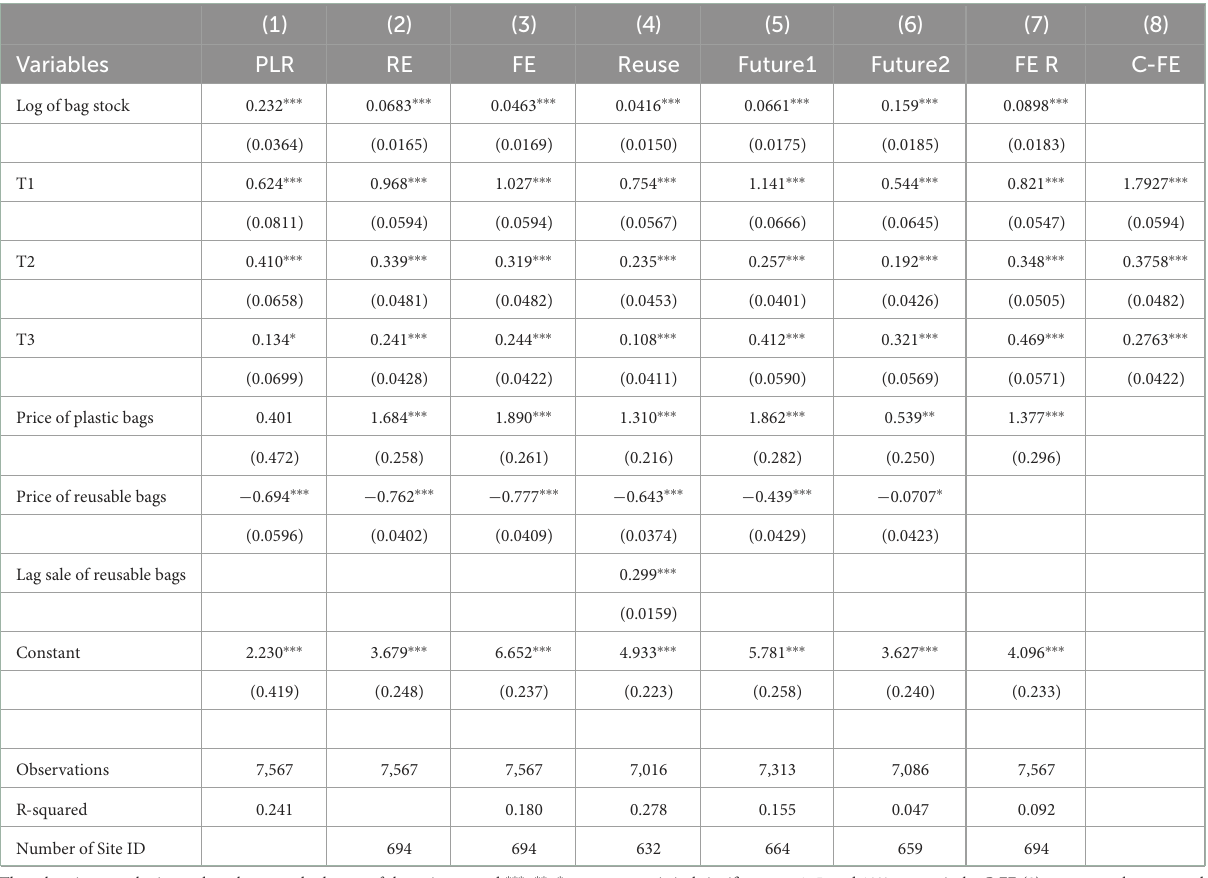
TABLE 1 Regression results for reusable bags